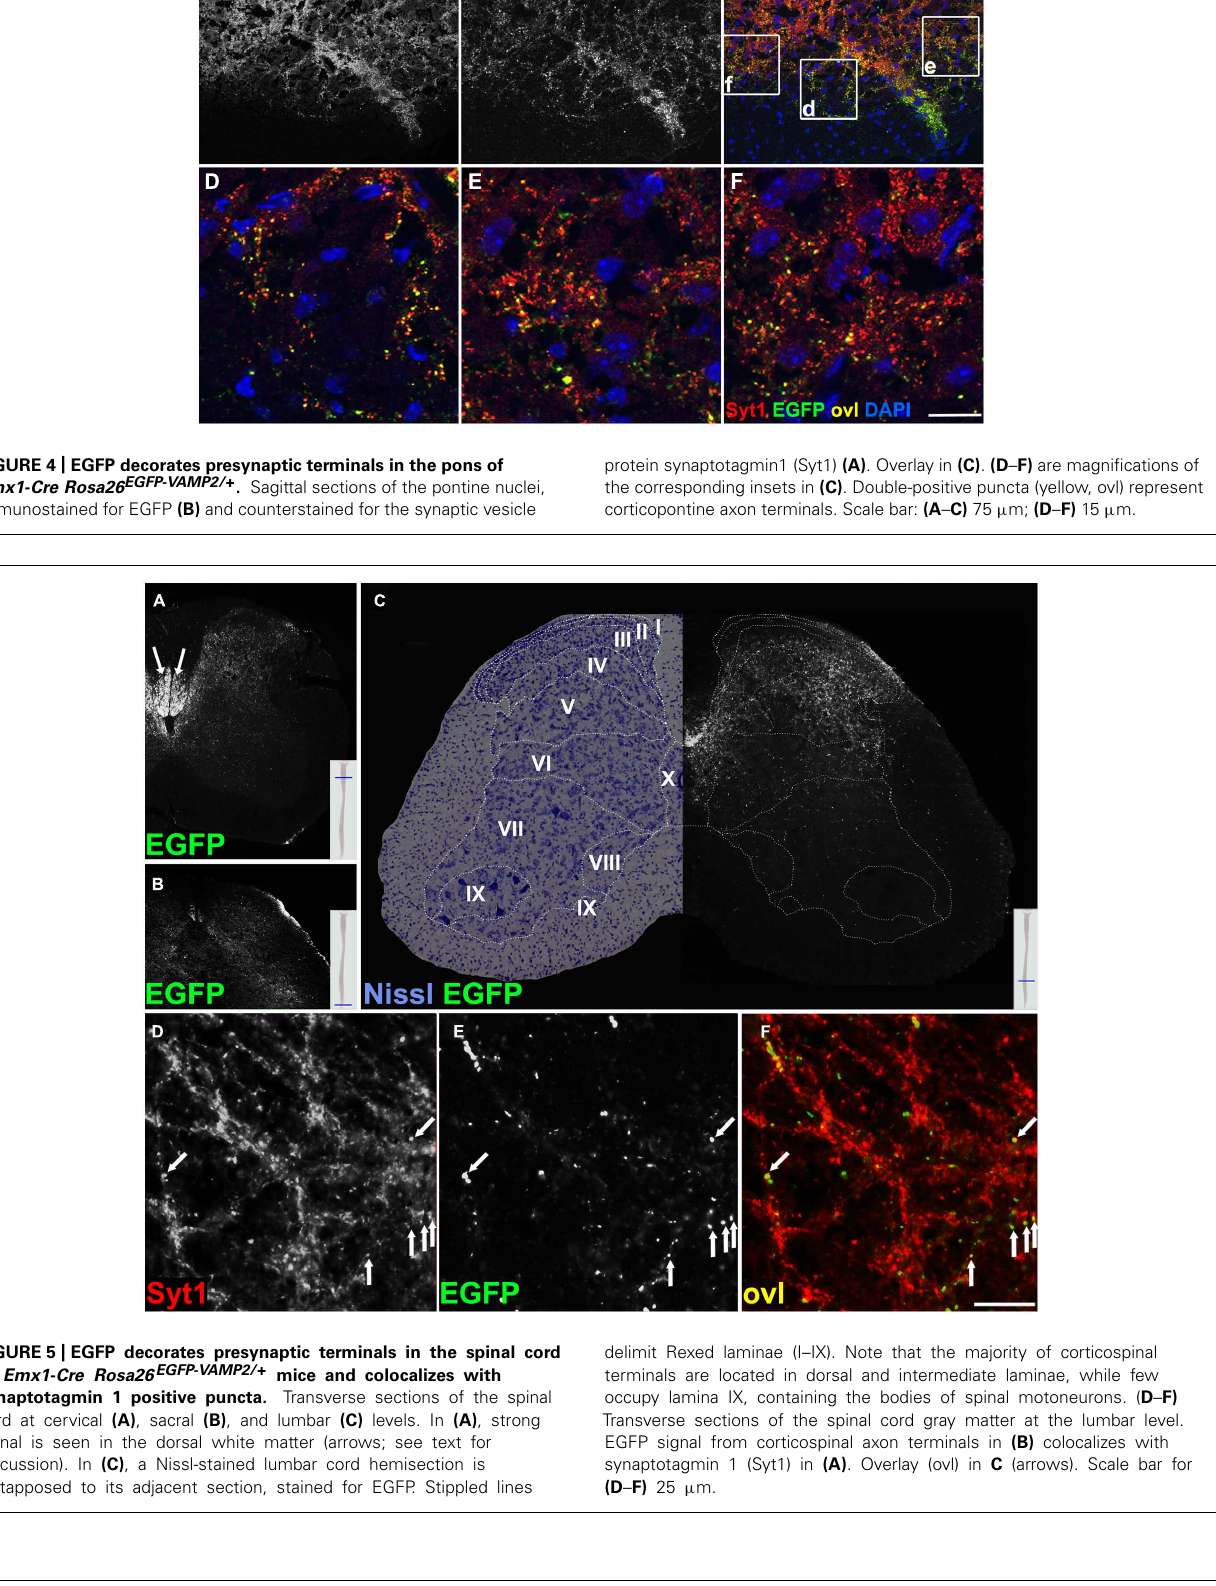
delimit Rexed laminae (I–IX). Note that the majority of corticospinal terminals are located in dorsal and intermediate laminae, while few occupy lamina IX, containing the bodies of spinal motoneurons . ( D – F) Transverse sections of the spinal cord gray matter at the lumbar level. EGFP signal from corticospinal axon terminals in (B) colocalizes with synaptotagmin 1 (Syt1) in (A) . Overlay (ovl) in C (arrows). Scale bar for (D – F) 25 μ